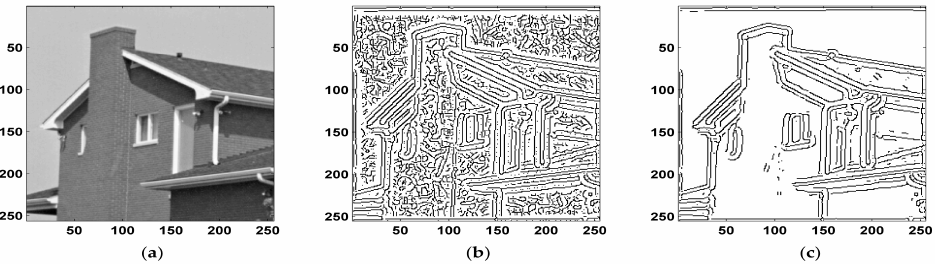
Figure 4. ( a ) House image, modulus maxima: ( b ) before thresholding, ( c ) after thresholding.